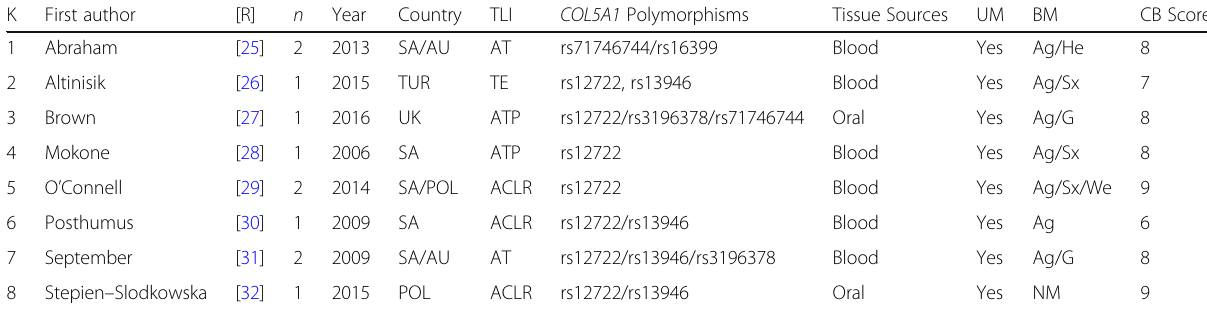
Table 1 Characteristics of the included studies that examined the association of COL5A1 polymorphisms with TLI studies